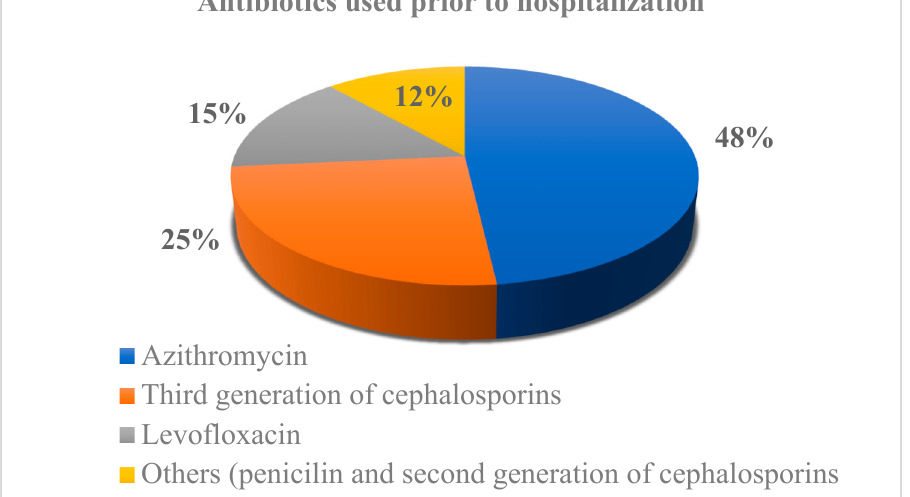
Figure 1. Number of antibiotics used prior to hospitalization.